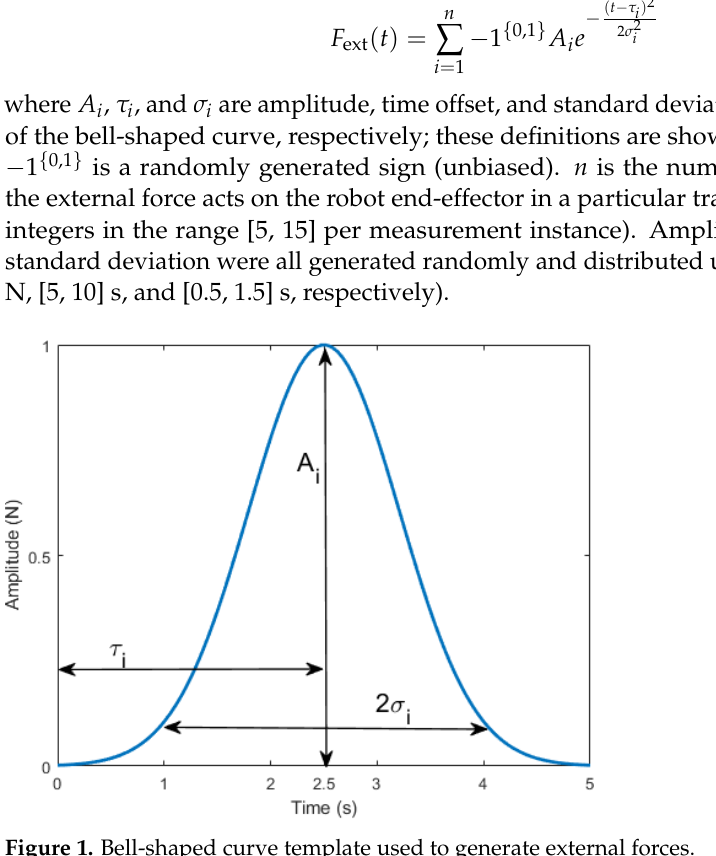
Figure 1. Bell-shaped curve template used to generate external